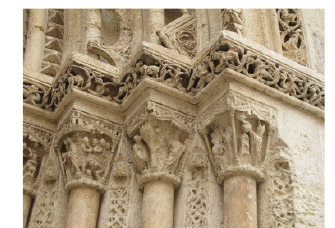
Figure 1: The Almoina Door in Valencia